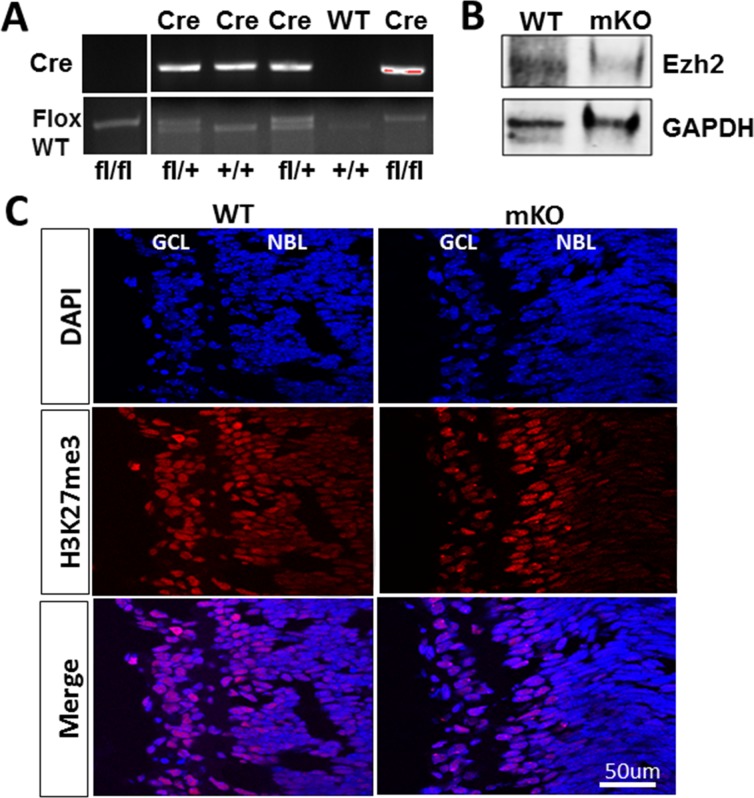
Deletion of Ezh2 driven by Math5-Cre in mKO mice.(A) PCR genotyping of Ezh2 and Cre genes. (B) Representative result of Western blot of Ezh2 expression in RGCs purified from P0 WT and mKO mice. GAPDH was used as a loading control. A strongly reduced level of Ezh2 was found in mKO RGCs as compared to WT RGCs. (C) Epifluorescence images of retinal sections taken from P0 WT and mKO mice that were immunolabeled for H3K27me3 (red) and nuclear marker 4’,6-Diamidino-2-Phenylindole (DAPI; blue). Note the higher level of H3K27me3 signals in the mKO retina compared to WT retina. Scale bar: 50 μm.